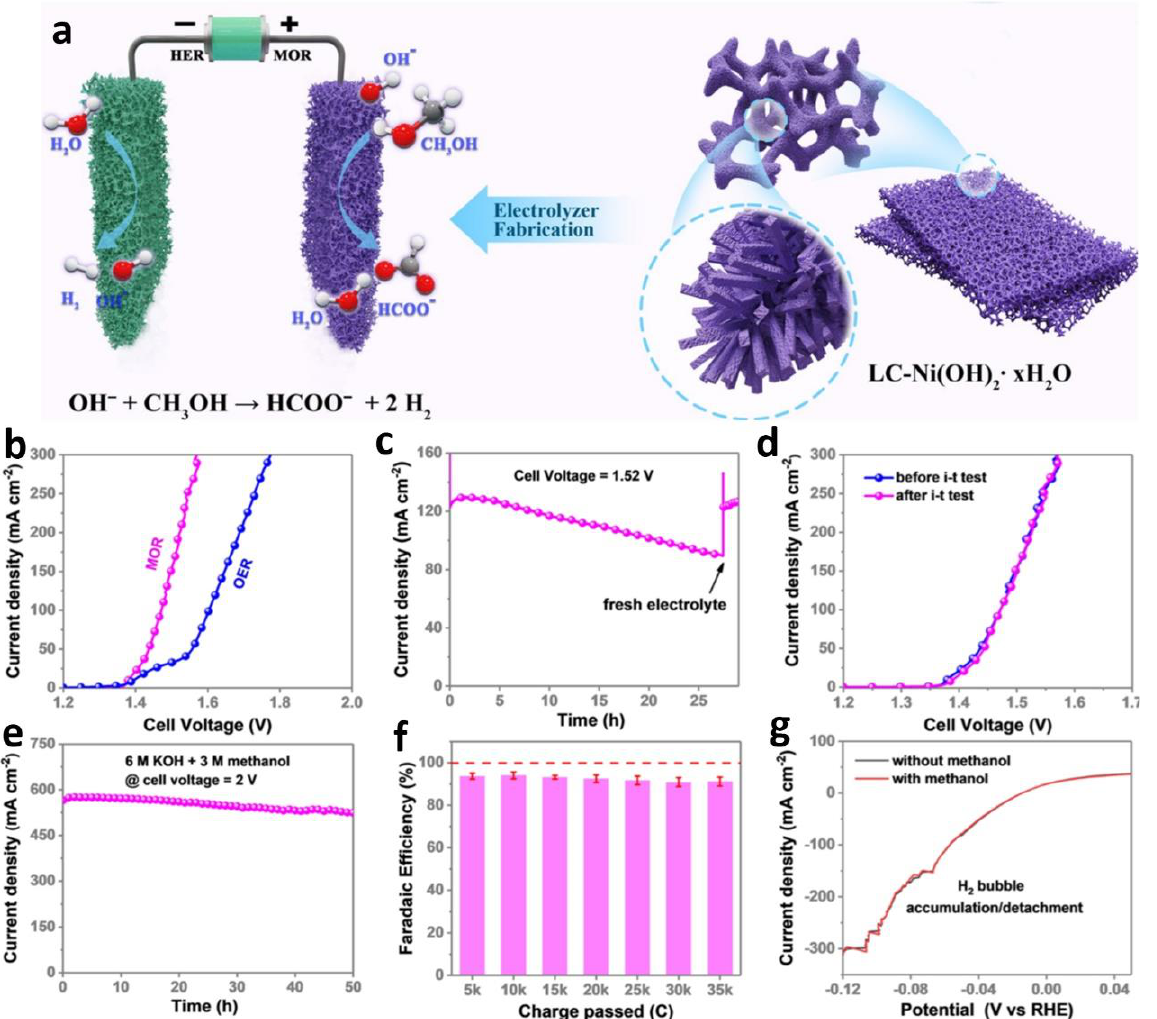
Figure 1. ( a ) Illustration of Ni(OH) 2 · xH 2 O nanorod array electrodes and their assembly of the hybrid electrolyzer coupling the HER and MOR. ( b ) The two-electrode LSV curves of Ni 4 Mo–MoO 2 and Ni(OH) 2 · xH 2 O towards the OER and MOR, respectively. ( c ) The i–t curves, ( d ) LSV curves before and after i–t tests and ( e ) i–t curves in 3M methanol and 6 M KOH for the hybrid Ni 4 Mo– MoO 2 ||Ni(OH) 2 · xH 2 O electrolyzer. ( f ) Faradaic Efficiency (FE) of the stability test of e. ( g ) The LSV curve of Ni 4 Mo–MoO 2 in 1 M KOH with and without 0.5 M methanol. Reproduced with permission